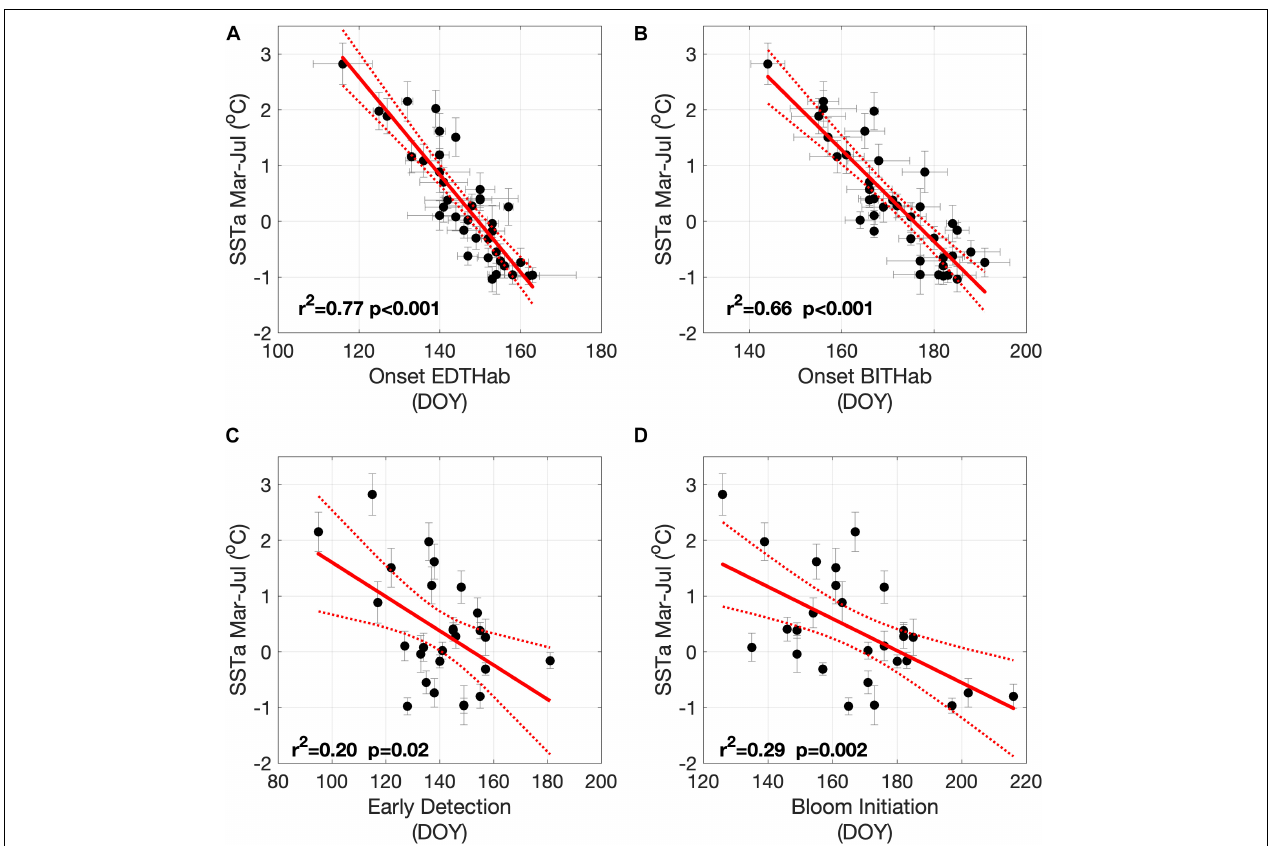
FIGURE 8 | Relationships between mean SSTa Mar–Jul and: (A) EDTHab mean occurrence date, (B) BITHab mean occurrence date, (C) early detection date and (D) bloom initiation date. Vertical and horizontal lines represent the standard